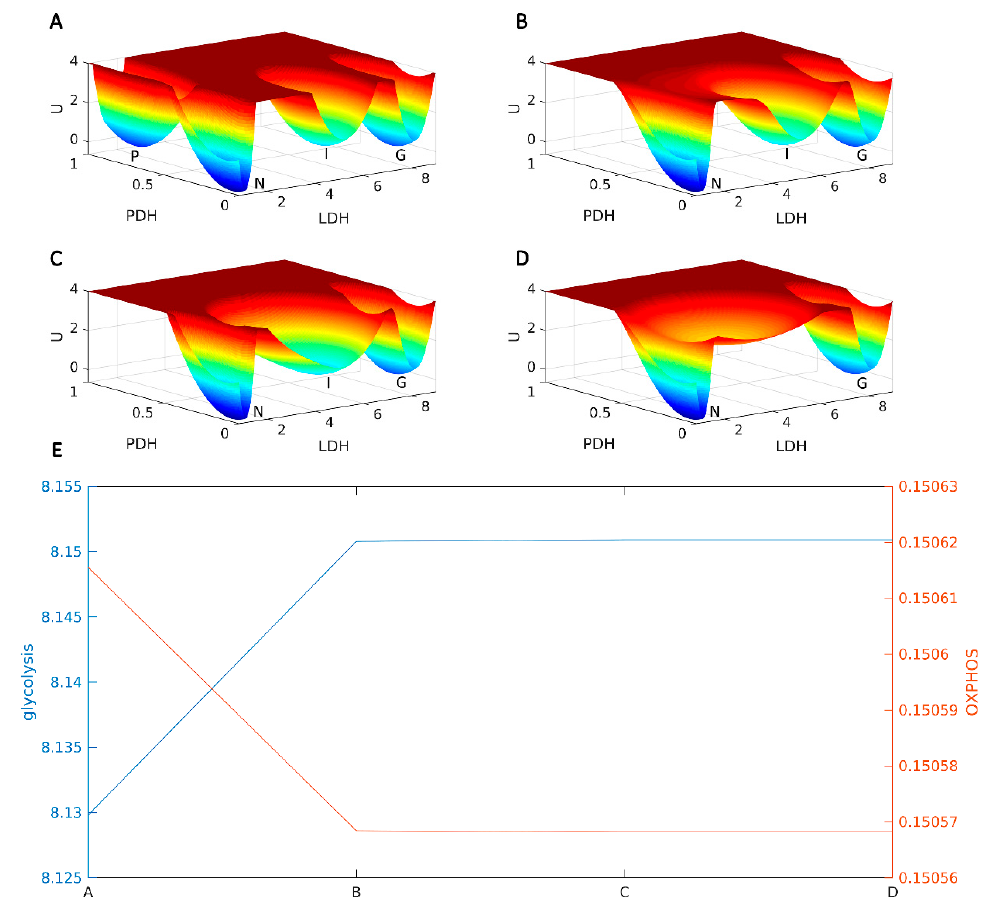
Figure 1. Metabolic landscape uncovers AMPK as a metabolic hub in cancer gene-metabolism inte- grative network. U is steady state probability distribution among variables. Lactate dehydrogenase (LDH) and pyruvate dehydrogenase (PDH) are chosen as an indicator of glycolysis and OXPHOS, respectively. Steady-state attractors, including normal state ( N ), cancer OXPHOS state ( P ), cancer glycolysis state ( G ), and cancer intermediate sate ( I ), are shown on the resulting quantified landscape topography. ( A – D ) Increasing AMPK expression results in a significant decline of OXPHOS level and a remarkable augment of glycolysis level. ( E ) The trend of AMPK-mediated metabolic switching in OXPHOS and glycolysis.